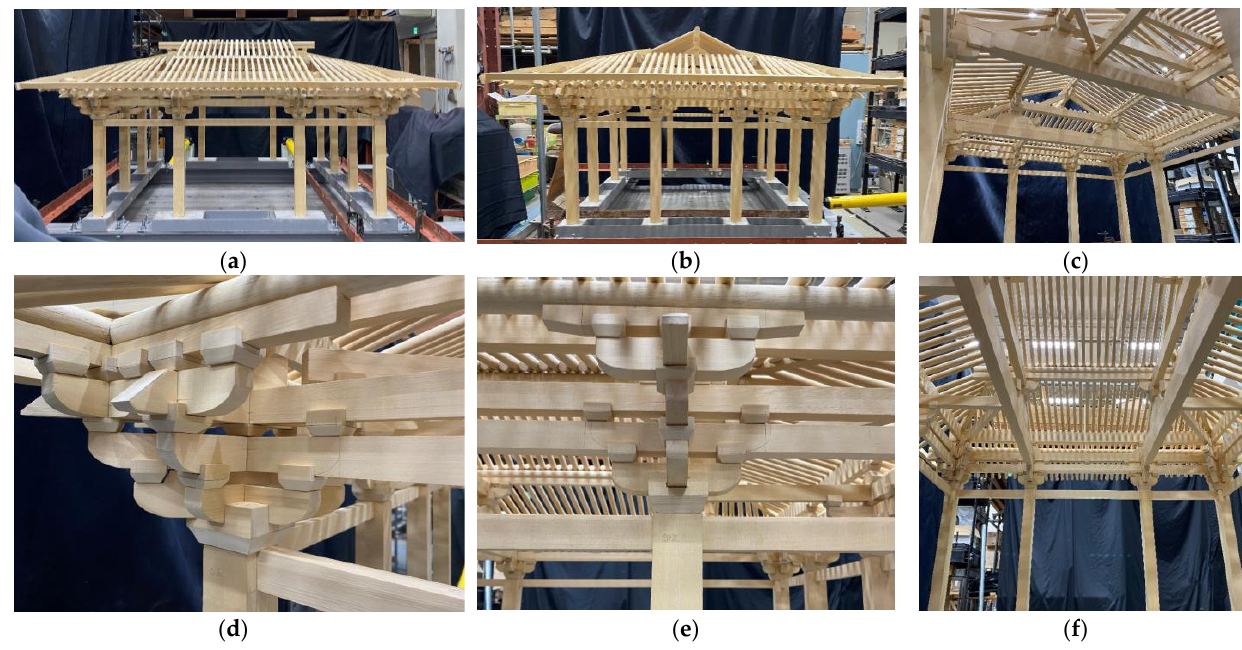
Figure 5. Photographs of the Nanchan Temple model (produced by the authors). ( a ) Frontal view. ( b ) Lateral view. ( c ) View from inside the hall. ( d ) Corner column Dou Gong. ( e ) Frontal column Dou Gong. ( f ) Sichuan Fu elevation view.